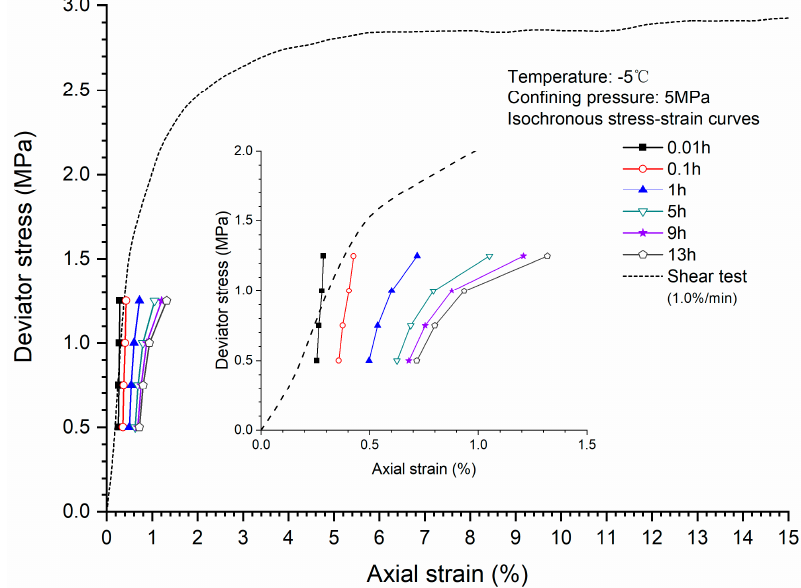
Figure 15. The isochronous stress-strain curves for methane hydrate-bearing frozen specimens under low deviator stresses. low deviator